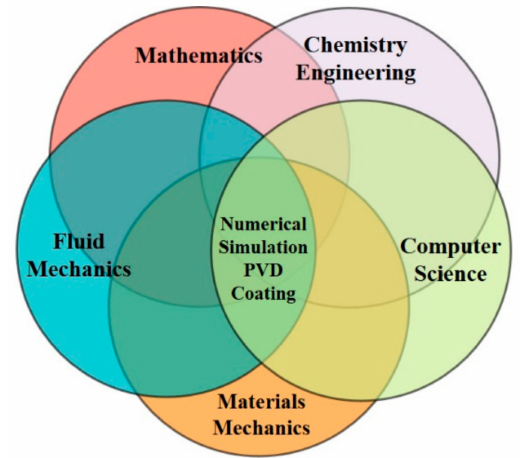
Figure 4. The evolution of different methods to solve engineering problems. FEM: finite element method; CFD: computational fluid dynamics.